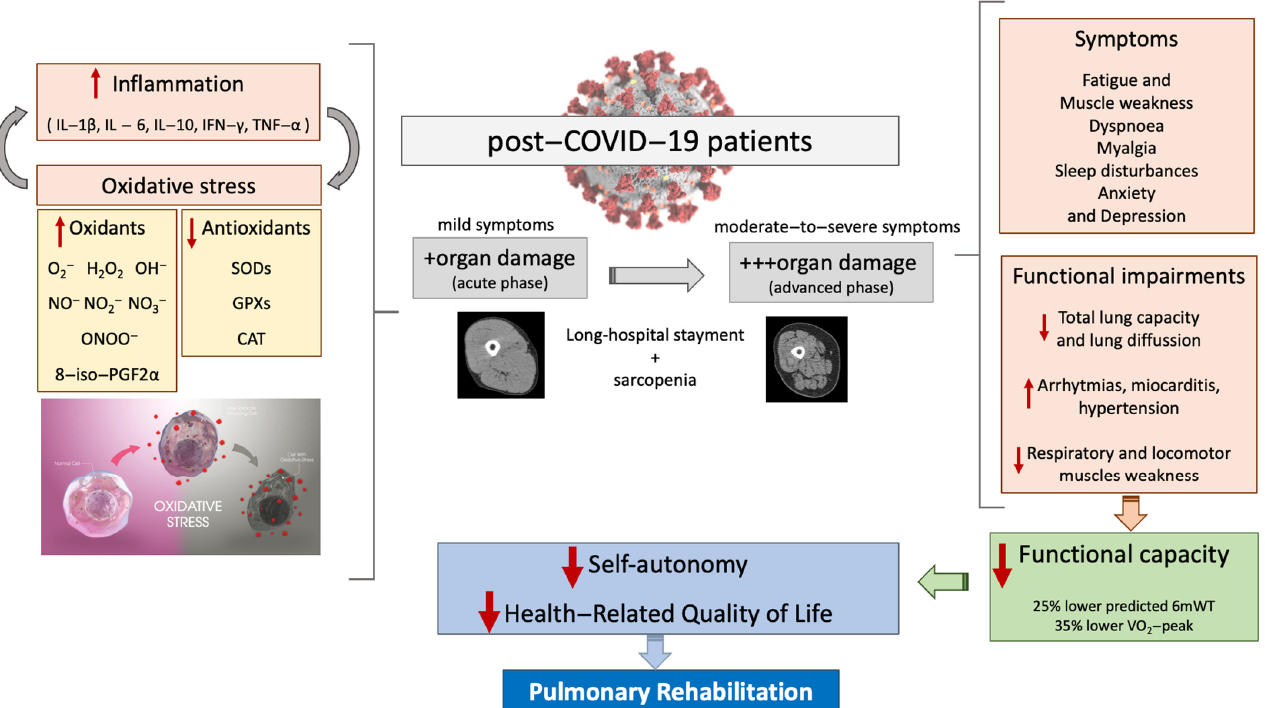
Figure 2. Overview of the factors involved in the deterioration of the functional capacity, self-autonomy, and health-related to quality of life in post-COVID-19 patients that need to be addressed by pulmonary rehabilitation. Abbreviations : IL = interleukin; IFN– γ = interferon gamma; TNF– α = tumor necrosis factor alpha; O 2 − = anion superoxide; H 2 O 2 = hydrogen peroxide; OH − = hydroxyl ion; NO − = nitric oxide; NO 2 − = nitrite; NO 3 − = nitrate; ONOO − = peroxynitrite; 8–iso PGF2 α = 8–iso–prostagladin F2–alpha; SOD = superoxide dismutase; GPX = glutathione peroxidase; CAT = catalase; 6mWT = six–minute walking test; VO 2 –peak = peak oxygen uptake.